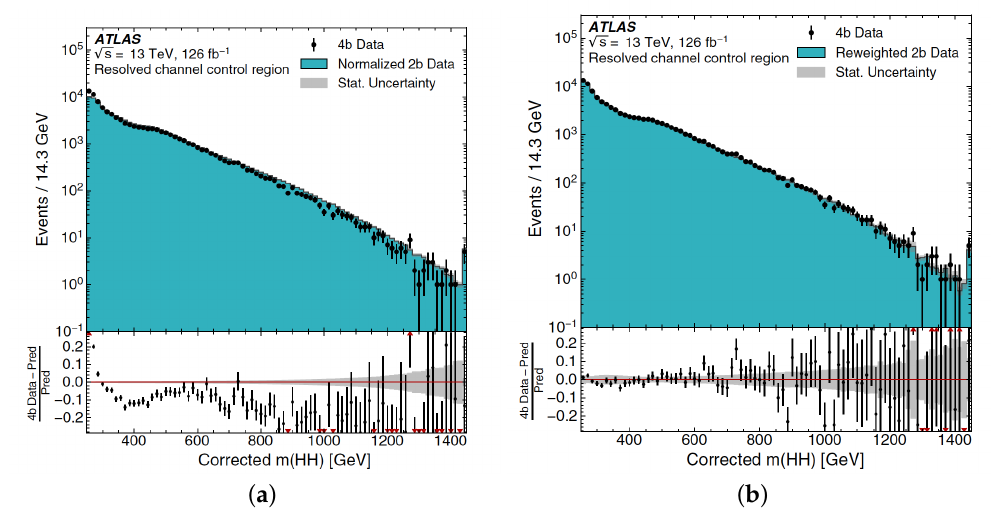
Figure 4. A comparison between the m ( HH ) distributions in the 2b (filled histogram) and in the 4b control regions (dots) is shown, where the 2b data are before and after the reweighting, respectively in ( a , b ). Here, the distributions are all normalized to the 4b event yields to purely compare the shapes